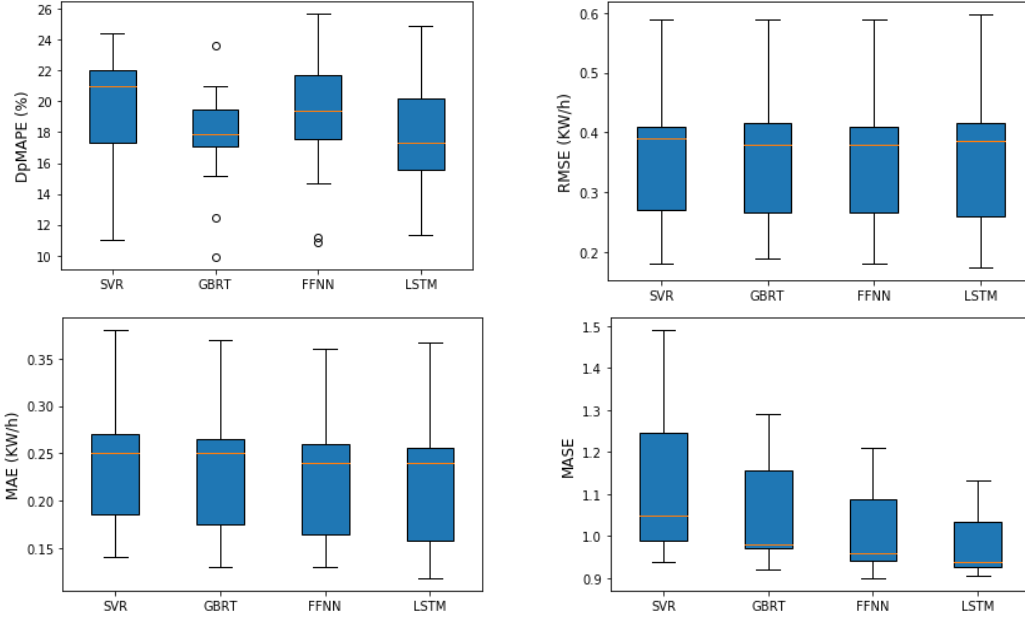
Figure 9. Comparison of models based on boxplot of forecasting error statistics.